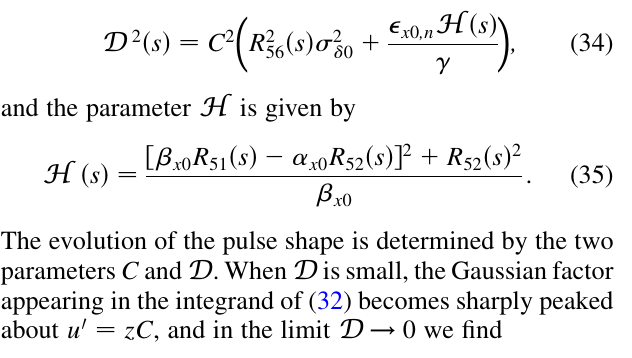
FIG. 4. The evolution of the longitudinal density (cid:1) within a chicane in the absence of collective effects is shown for the ^ D ¼ 2% , 4%, 6%, 8%, and 10%, demonstrating the values and transverse effect of nonzero initial energy spread (cid:2) (cid:12) 0 on the bunch profile. The dashed line illustrates emittance (cid:4) x 0 ;n ¼ L=C denotes the compressed bunch the initial density and L f length.